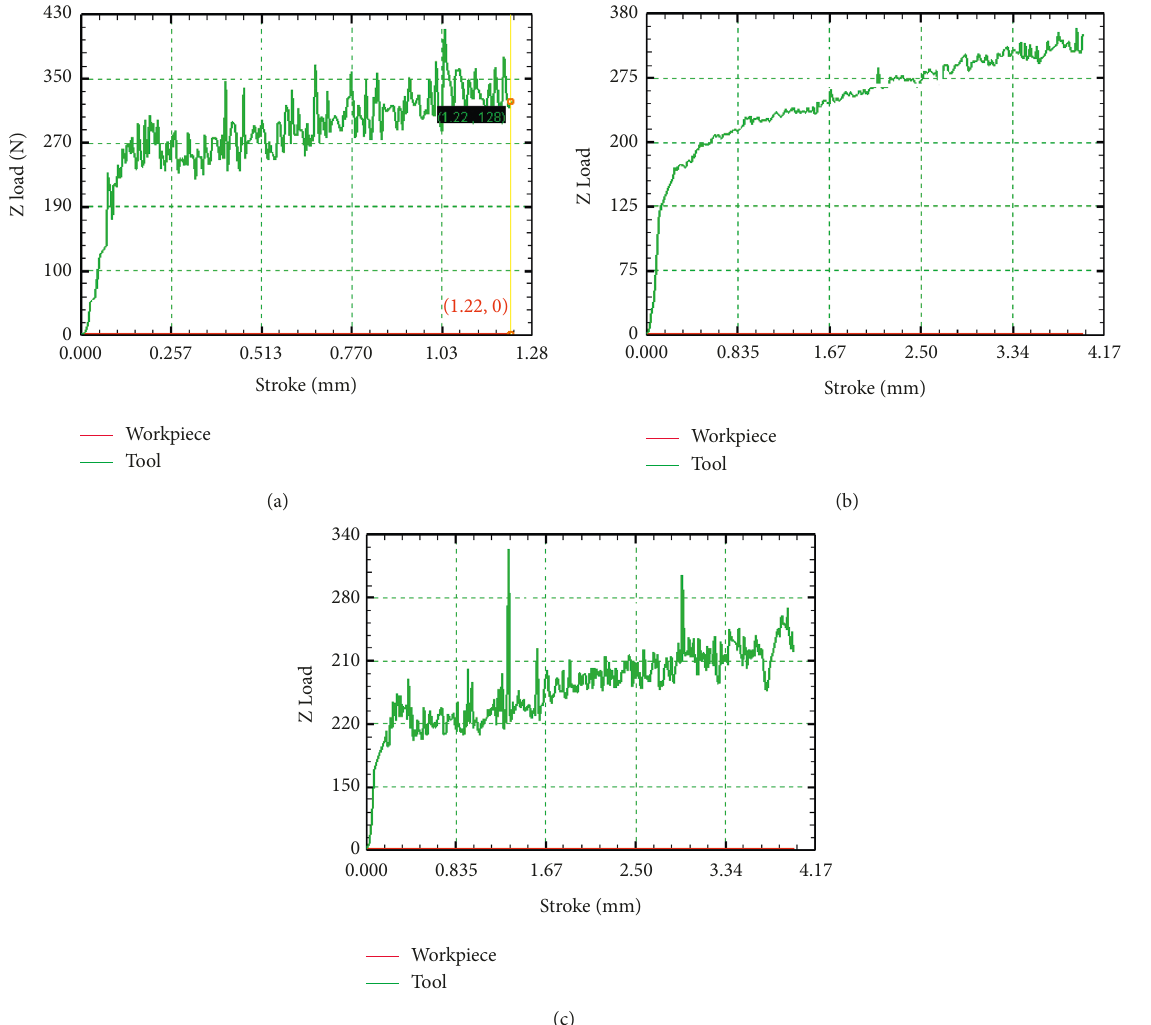
Figure 2: Simulated images of cutting force in the machining zone. (a) Cutting force: simulated at (V) 60 m/min, (S) 0.15 mm/rev, ap: 0.75mm. (b) Cutting force: simulated at (V) 120m/min, (S) 0.25mm/rev ap: 1.25mm. (c) Cutting force: simulated at (V) 150m/min, (S) 0.55mm/rev a p : 1.0